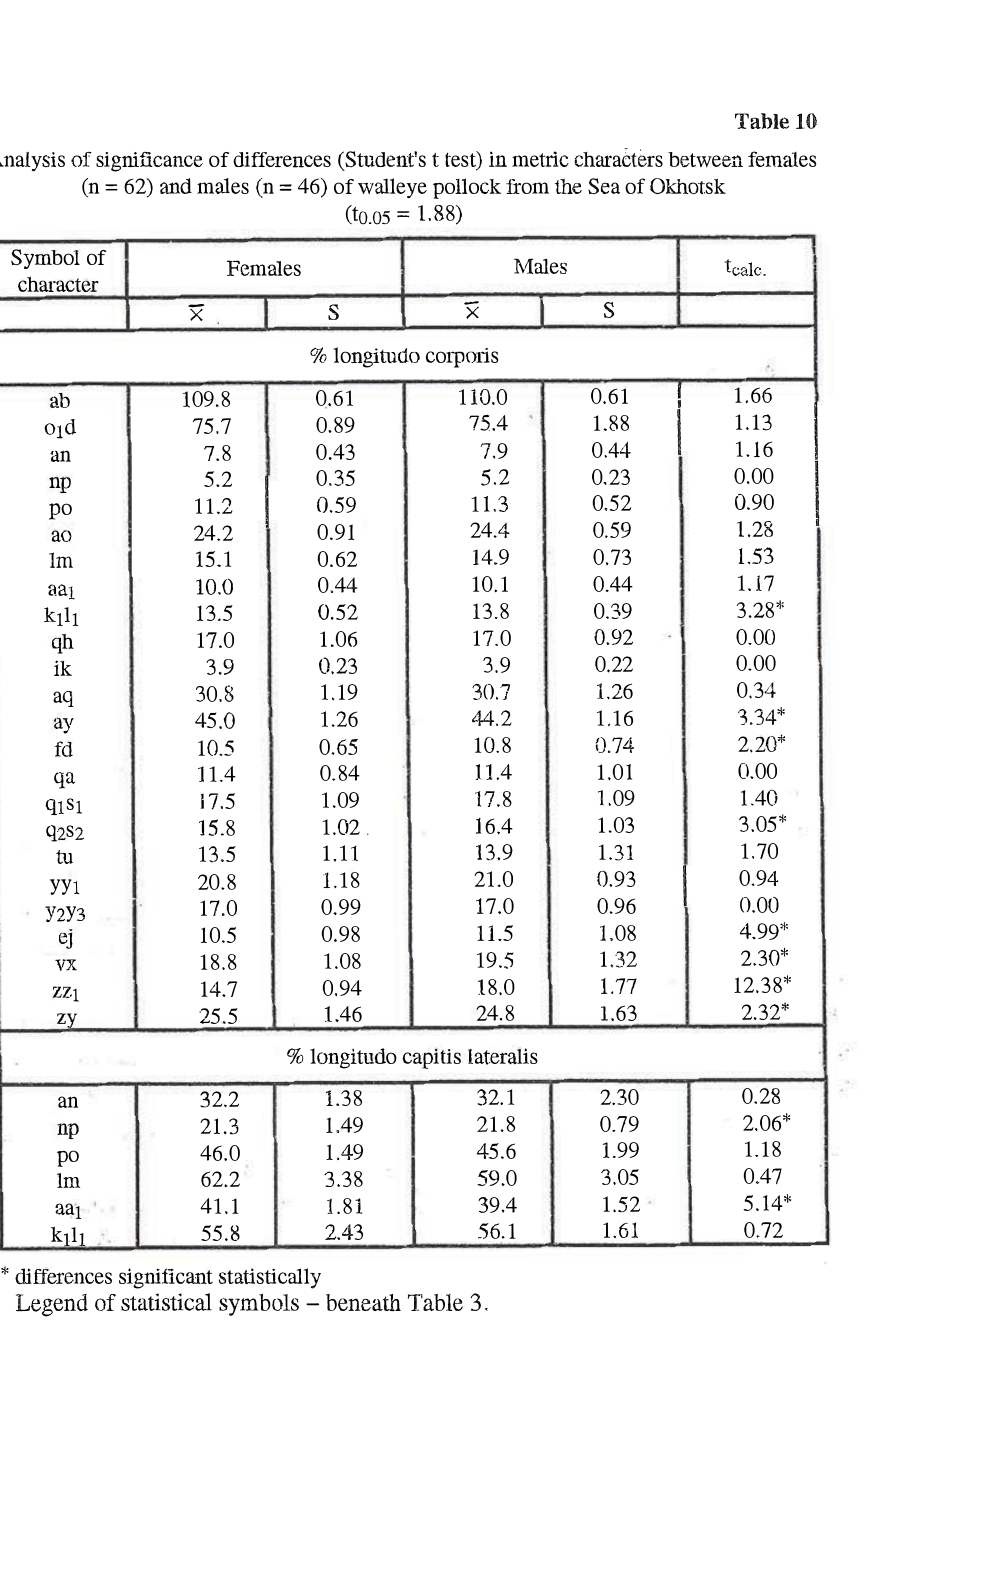
Analysis of significance of differences (Student's t test) in metric characters between females (n = 62) and males (n = 46) of walleye pollock from the Sea of Okhotsk (to.os =